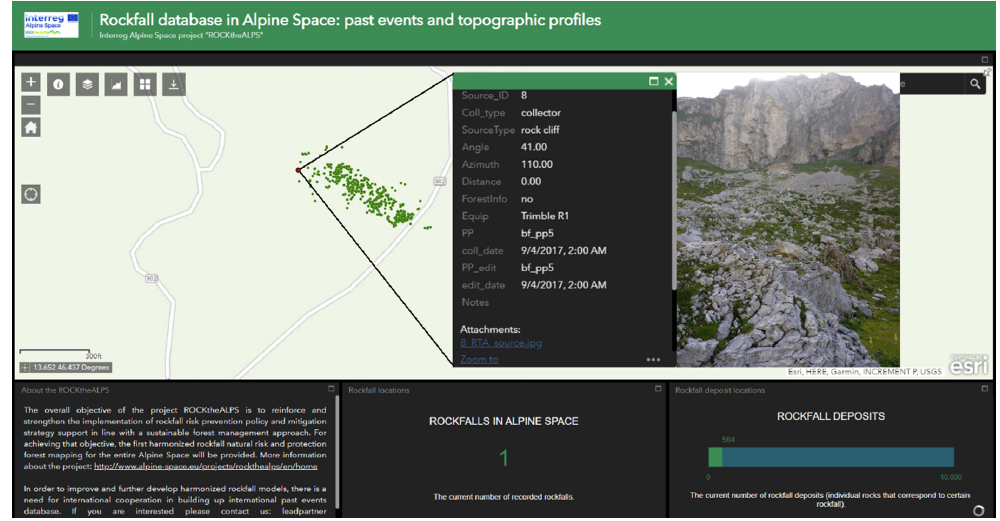
Figure 6. Pop-up window with attributes of either rockfall source or deposit area. If the feature has an attachment one can open and view the attached pictures. attachment one can open and view the attached pictures.